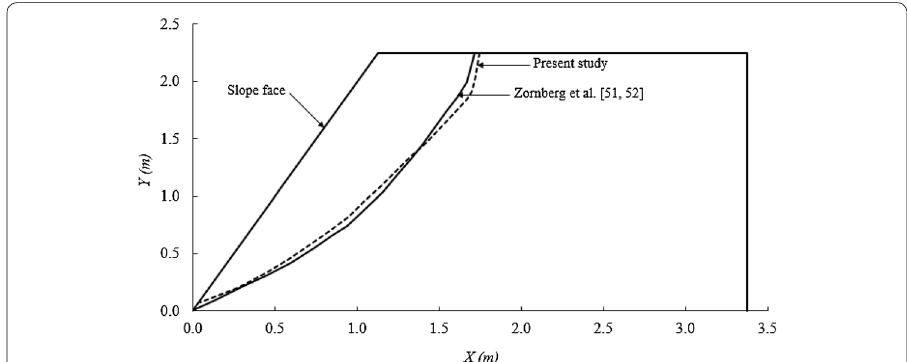
Fig. 2 Comparison of failure surfaces between the present study and works of Zonberg et al. [30,